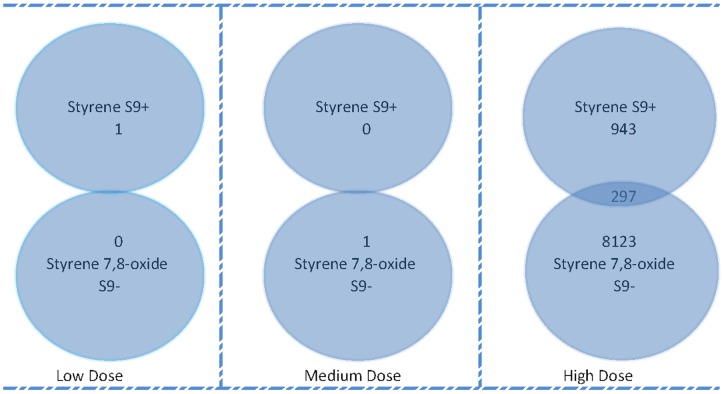
Genes in common between Styrene (S9+) and Styrene 7,8-oxide (S9-).Venn diagram indicating the number of genes common between styrene (S9+) and styrene 7,8-oxide (S9-) at low, medium and high dose (q-value<0.15) exposed TK6 cells. The number of overlapping genes at each of the dose levels were not significant (q-value<0.15) by Fisher's exact test.